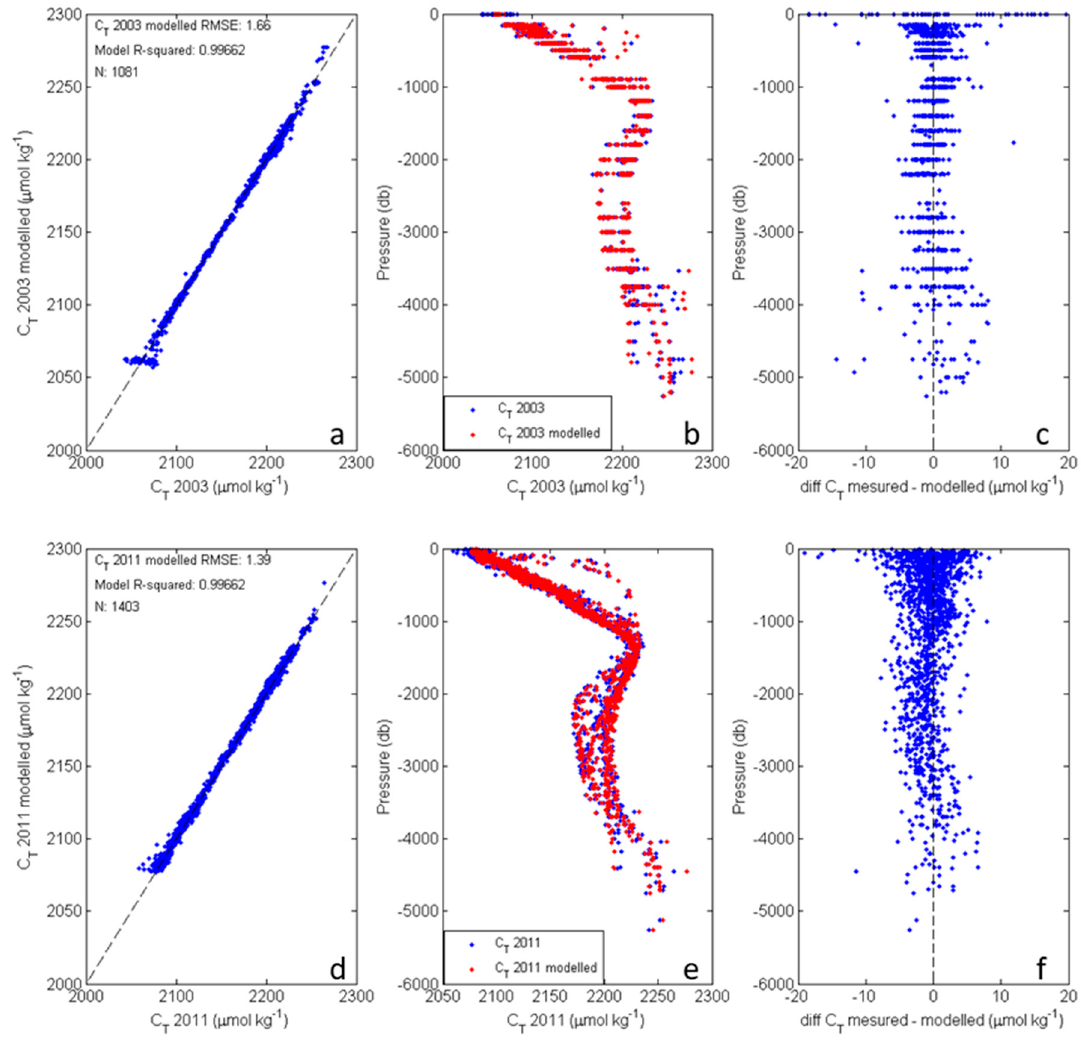
Figure 4. C T model results considering the A10 section of 2003 ( a – c ) and 2011 ( d – f ); measured vs. modeled C T ( a , d ), including the RMSE of the model equation, measured vs. modeled r 2 , and number of measurements (N); measured (blue dots) and modeled (red dots) vertical profiles ( b , e ); vertical profiles of the difference between the measured and modeled C T ( c , f ). The C T and C T -differences units are μ mol kg − 1 .